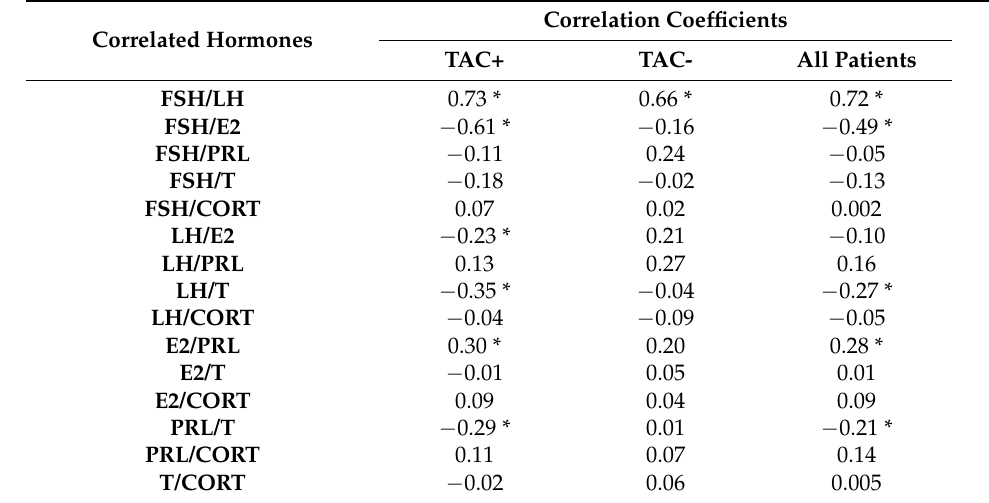
Table 6. Correlation coefficients of FSH, LH, T, E2, PRL, CORT in grafted patients, by TAC intake. Correlated Hormones